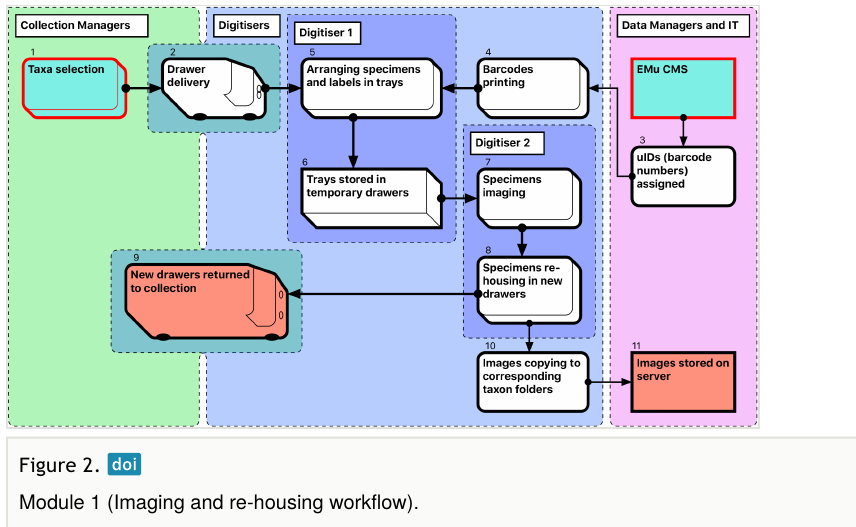
Module 1 (Imaging and re-housing work fl